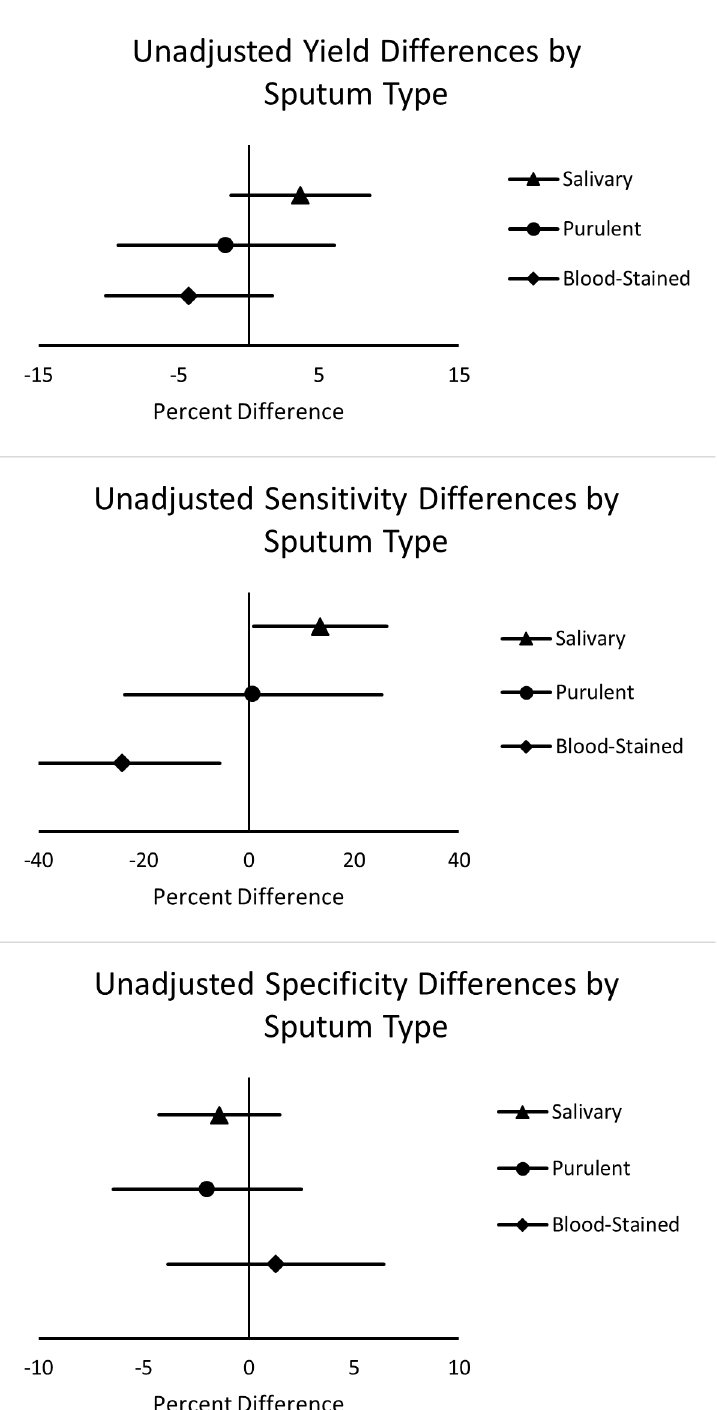
Fig 2. Xpert proportion positive differences and unadjusted differences in sputum Xpert sensitivity and specificity, stratified by sputum quality * . Legend: * Mucoid sputum utilized as the reference group.